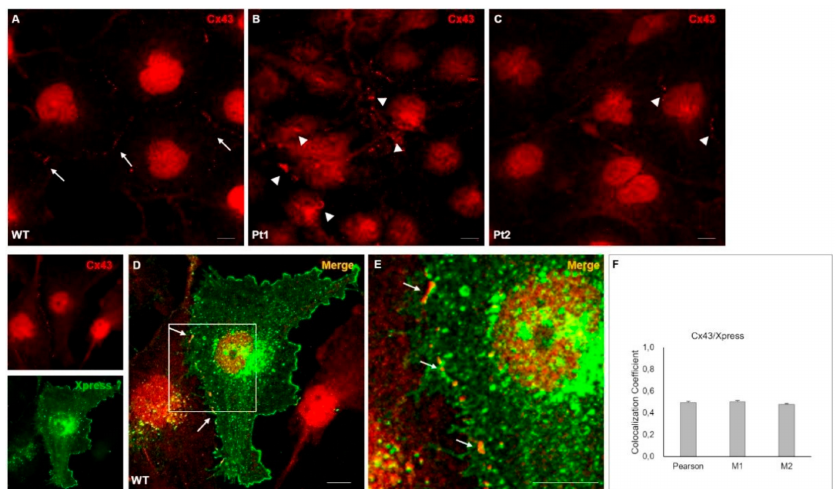
Figure 3. Cx43 protein localization in U251 astrocytoma cells overexpressing MLC1 WT or carrying the pathological mutations Pt1 and Pt2: ( A ) IF staining of WT MLC1-expressing cells by using the anti-Cx43 pAb (red) shows Cx43 protein distribution in discrete areas of the plasma membrane where cell-cell contacts occur (arrows). ( B , C ) In Pt1 and Pt2 mutant cells, Cx43 signal (red) is mainly detected in